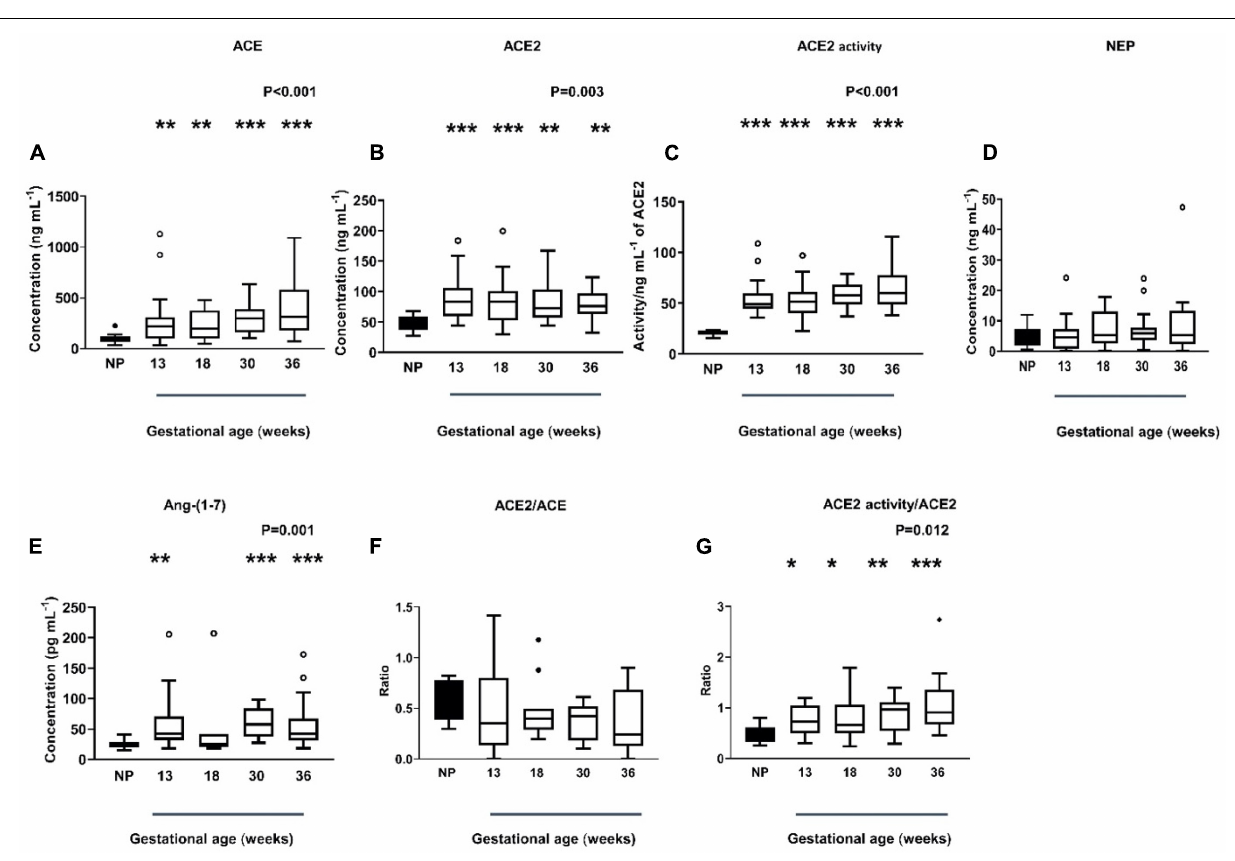
FIGURE 3 | Plasma levels and activity of ACE, ACE2, and NEP in non-pregnant (NP) and pregnant women (A–D) . Plasma levels of Ang-(1-7) were measured by radioimmunoassay in NP and pregnant women (E) . Plasma ACE2/ACE ratio and ACE2 activity/ACE ratio in NP and pregnant women (F,G) . Data are expressed as median and interquartile range. n = 9–10 samples for the NP group (black box), n = 7–35 samples/group for 13, 18, 30, and 36 weeks of normal pregnancy (white box). P -values were calculated using a Kruskal–Wallis test (with Dunn’s multiple comparison test). * P < 0.05, ** P < 0.01, *** P < 0.001 versus